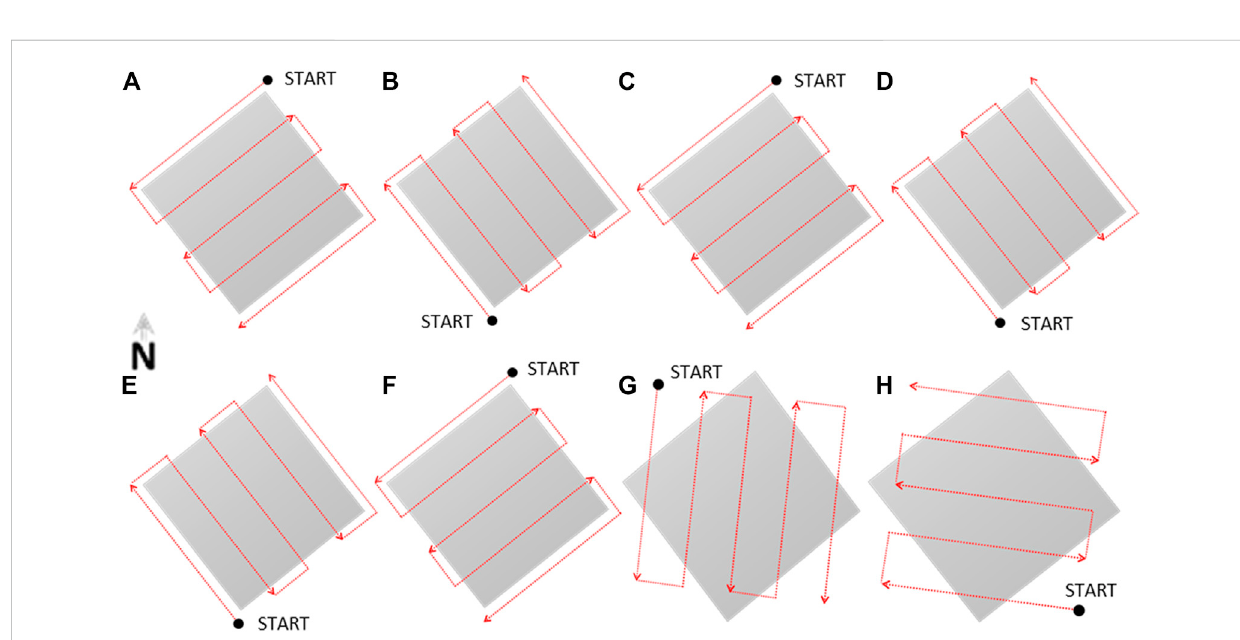
FIGURE 3 Different scenarios of the MBES